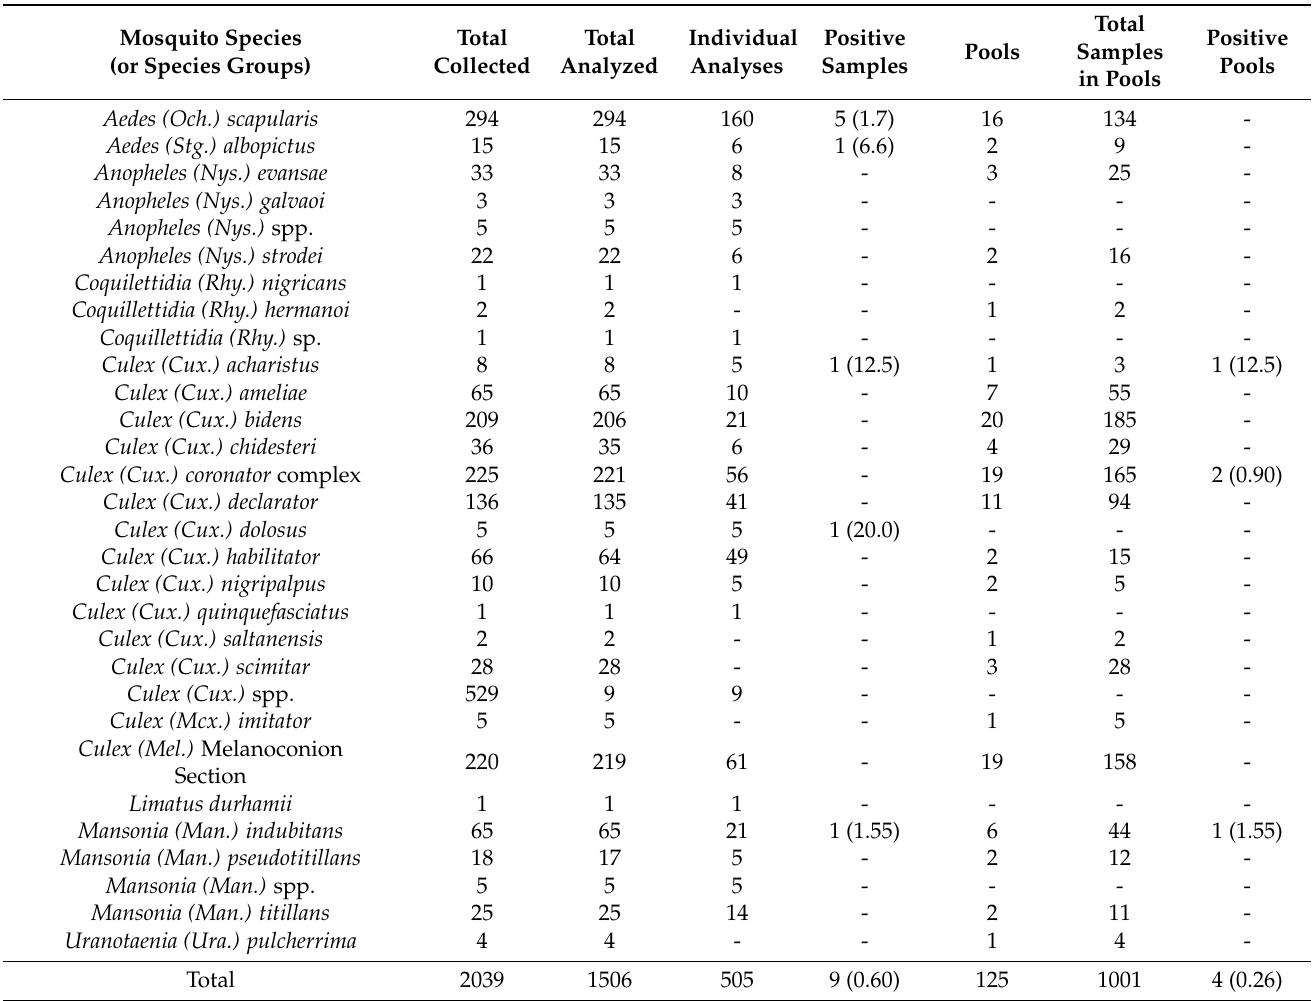
Table 1. Diversity of Culicidae species and Plasmodium/Haemoproteus prevalence in mosquitoes from S ã o Paulo Zoo. Rate of infection (%) for each mosquito species or group is given in